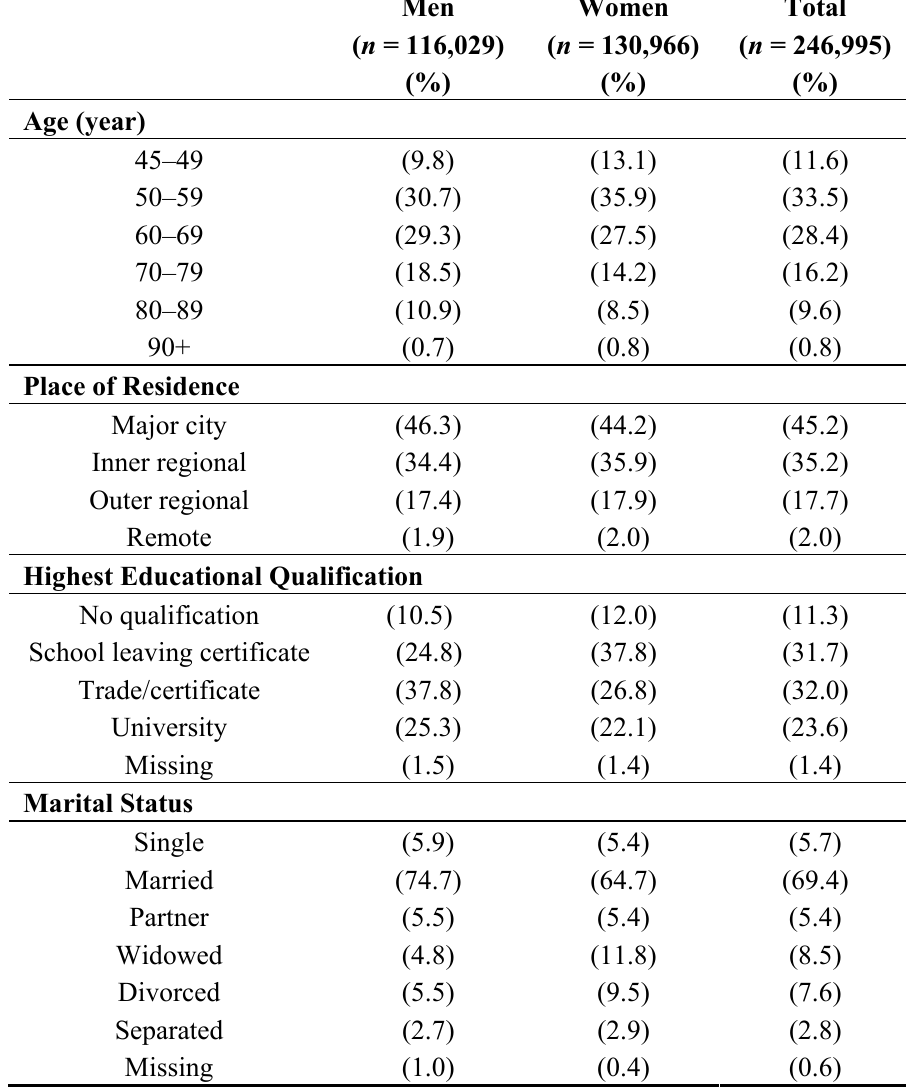
Table 1. Socio-demographic characteristics of participants, by sex.